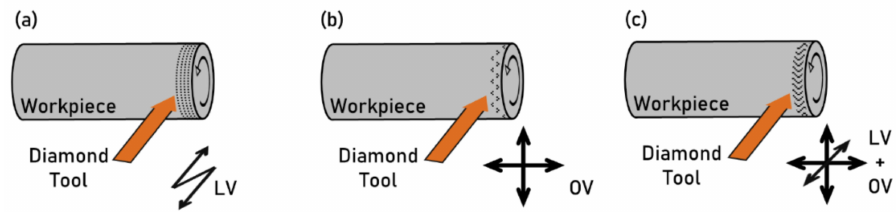
Figure 2. Different vibrational modes for the ultrasonic assisted turning process. ( a ) longitudinal vibration (LV); ( b ) orthogonal vibration (OV); ( c ) LV and OV applied